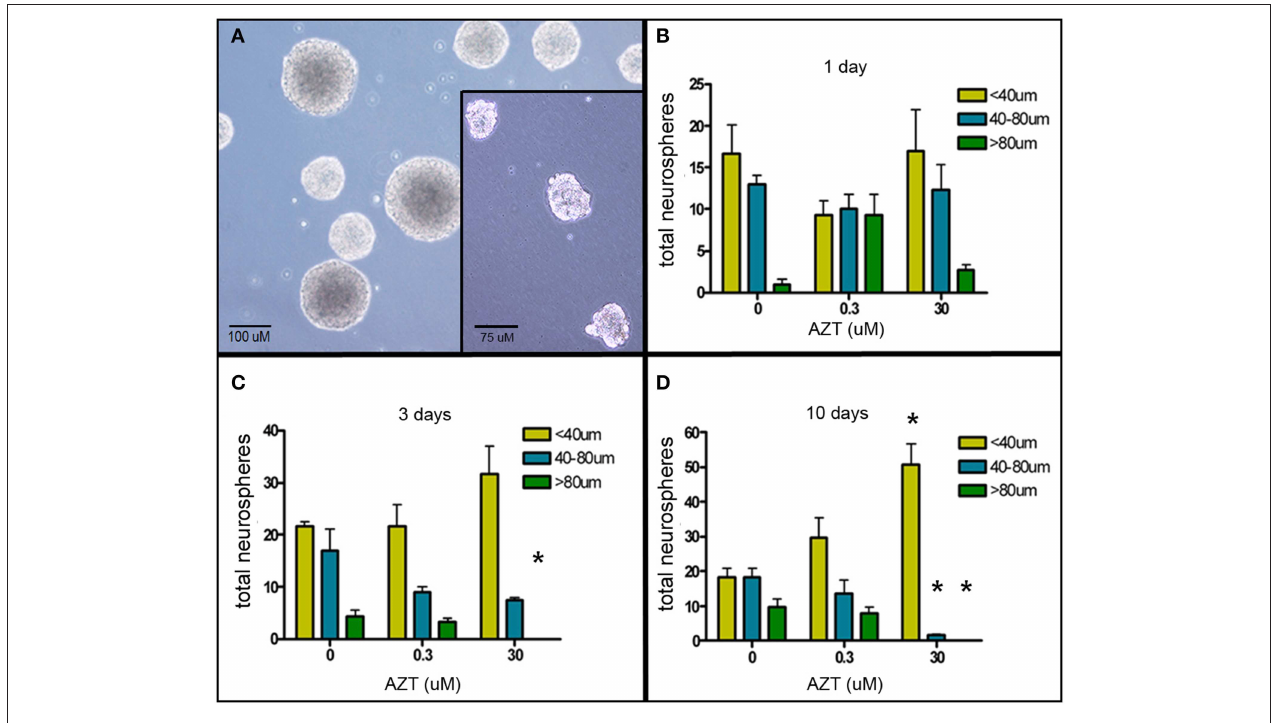
FIGURE 2 | AZT reduces neurosphere size. Single-cell dissociates of primary postnatal SEZ form neurospheres within 10 days in vitro . AZT (0, 0.3, or 30 µ M) was added to the culture medium for 1, 3, or 10 days beginning on in vitro day 1, and neurospheres were quantified and measured on in vitro day 11. (A) Representative untreated control neurospheres on day 11. (Inset in A ) Representative day 11 neurospheres treated with 30 µ M AZT for 3 days. AZT reduces neurosphere size in both a concentration- and time-dependent manner (B–D) . With increasing exposure time and increasing dose there is a shift in the distribution of neurosphere sizes. While total neurosphere number remains constant among the control and treated groups, AZT induces an increase in smaller neurospheres at the expense of